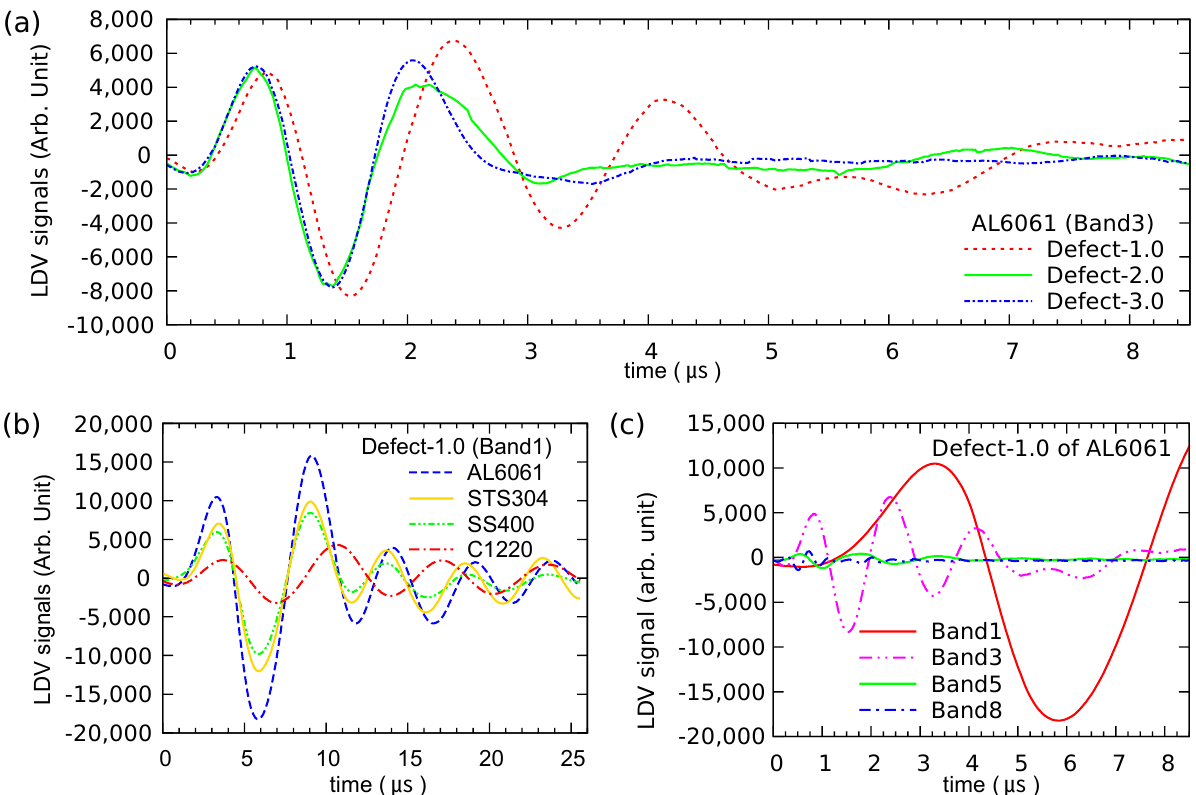
Figure 9. A-scan graphs showing the effect of the defect depth, band, and material: ( a ) A-scan data of the center of Defects-1.0, -2.0, and -3.0 in aluminum alloy AL6061 in Band3, ( b ) A-scan data of the center of Defect-1.0 in the AL6061, STS304, SS400, and C1220 specimens in Band1, and ( c ) A-scan data of the center of Defect-1.0 in aluminum alloy AL6061 in Band1, Band2, Band5, and